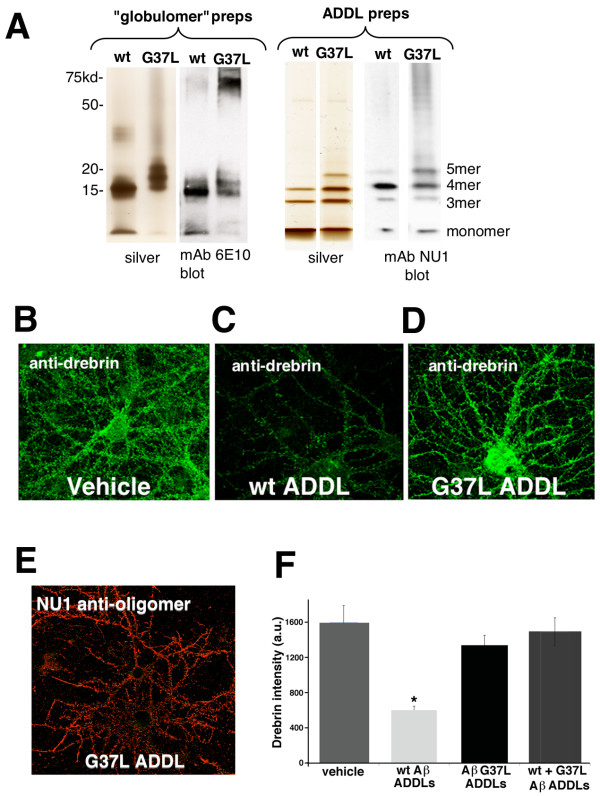
Toxicity of Aβ wild type and Aβ G37L oligomers (ADDLs) in primary hippocampal cultures. A. SDS-PAGE fractionation of oligomers formed from synthetic Aβ1-42 wild type or G37L. The left panel displays oligomers formed using the "globulomer" preparation of Barghorn et al [21]. The right panel displays oligomers formed using the "ADDL" preparation originally described by Lambert et al [24]. Monoclonal antibody 6E10 recognizes an epitope included in Aβresidues 16-24; mAb NU1 preferentially binds oligomeric Aβ. Note that for both oligomer preparations Aβ G37L tends to form higher molecular weight species. B - D. Representative epifluorescence images of anti-drebrin staining of embryonic rat hippocampal neurons treated after 21 days in culture for 24 hr with vehicle (B), 500 nM Aβ wild type ADDLs (C), or 500 nM Aβ G37L ADDLs (D). Note the strong reduction of drebrin staining is induced by exposure to wild type, but not G37L, ADDLs. E. Hippocampal neurons treated with Aβ G37 ADDLs, washed, fixed, and probed with anti-Aβ oligomer antibody NU1. Note robust binding of the Aβ G37L ADDLs to neurons. F. Quantification of drebrin immunoreactivity in hippocampal neurons exposed to Aβ wild type or G37L ADDLs. Exposure to Aβ wild type ADDLs significantly reduced drebrin immunoreactivity relative to vehicle-treated neurons (*P < 0.01), but no significant reduction was found for Aβ G37L ADDLs or ADDLs formed from a 1:1 mixture of Aβ wild type and G37L (Tukey Multiple Comparisons test).